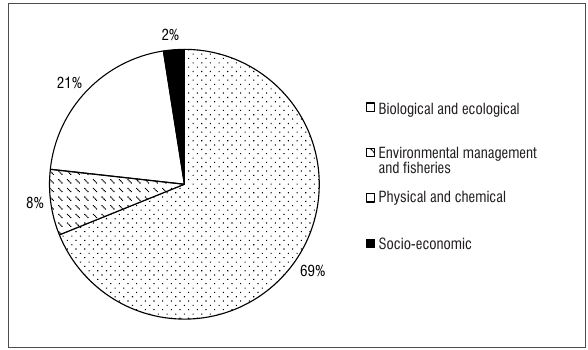
Figure 5: Percentage of theses in each of four categories of research related to South African estuaries.